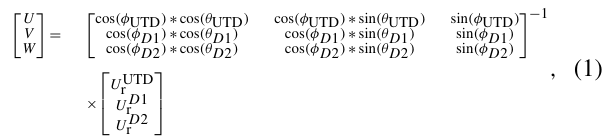
Table 2. Error analysis on the retrieval of the wind velocity compo- nents from triple-Doppler lidar measurements for different heights consequent to azimuthal and elevation angles of the three lidars. Values are dimensionless. Height